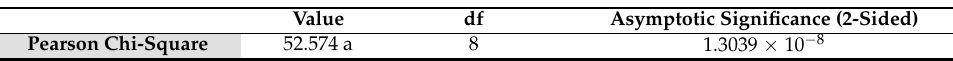
Table 9. Chi-square tests.